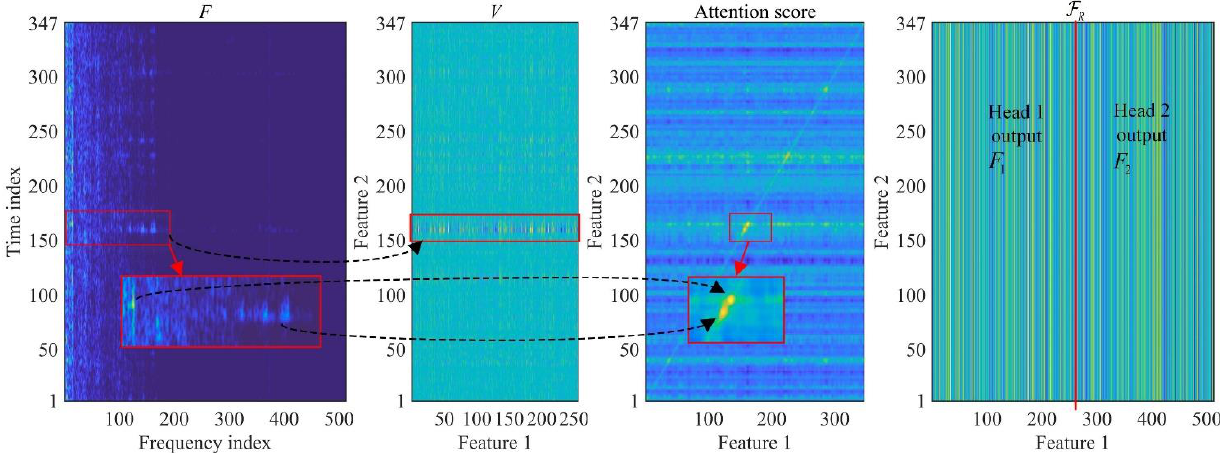
Figure 9. Visualized forward inference process.